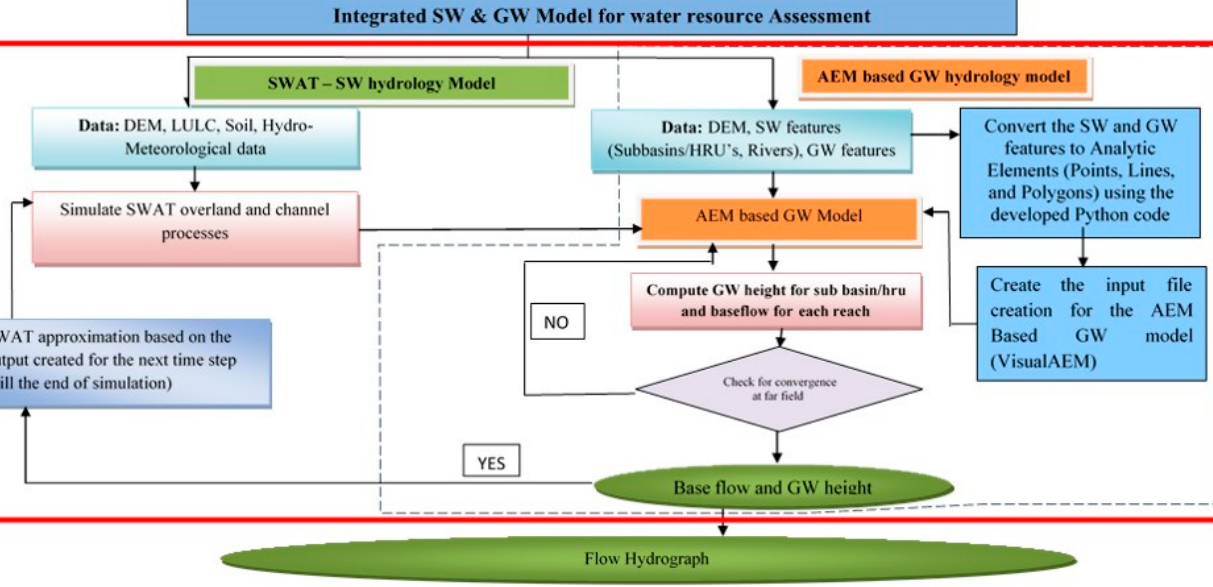
Figure 2. Methodology of integrated SWAT-AEM Model computation.